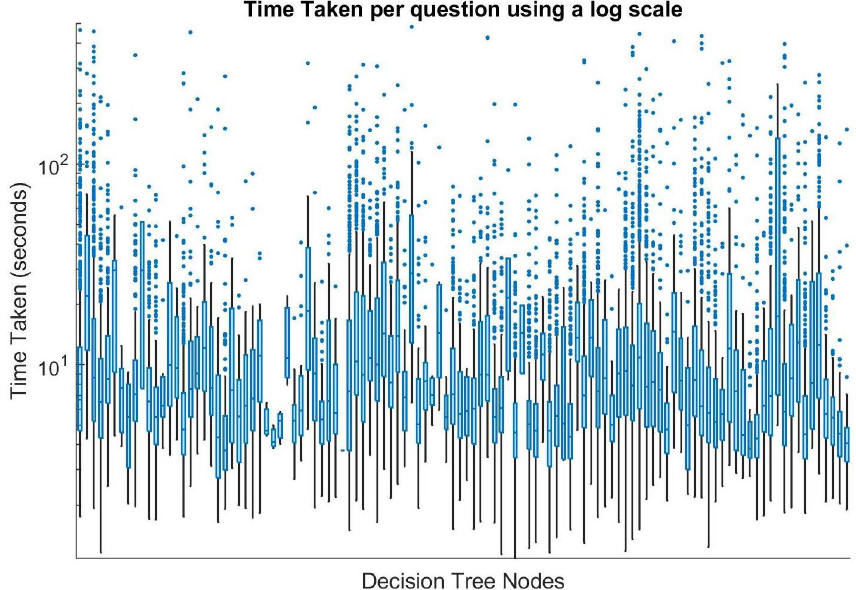
Figure 4. Box and whisker plot for the response times (vertical axis) of individual nodes (horizontal axis). Any data point which is greater than 1.5 times the interquartile range away from either the upper or lower quartile is denoted an outlier and marked by a circle. The data is displayed on a log axis for response